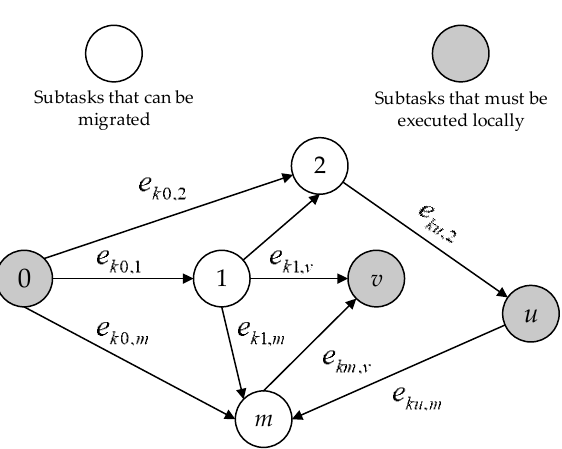
Figure 2. The fine-grained topology model for task k.